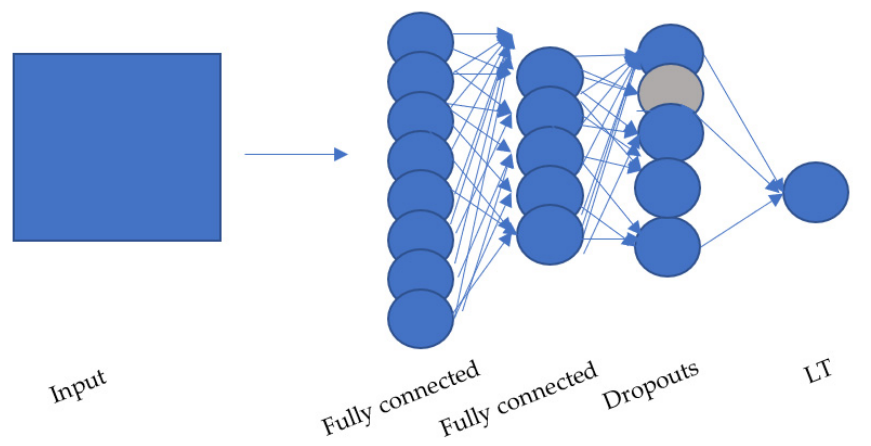
Figure A2. CV model structure.